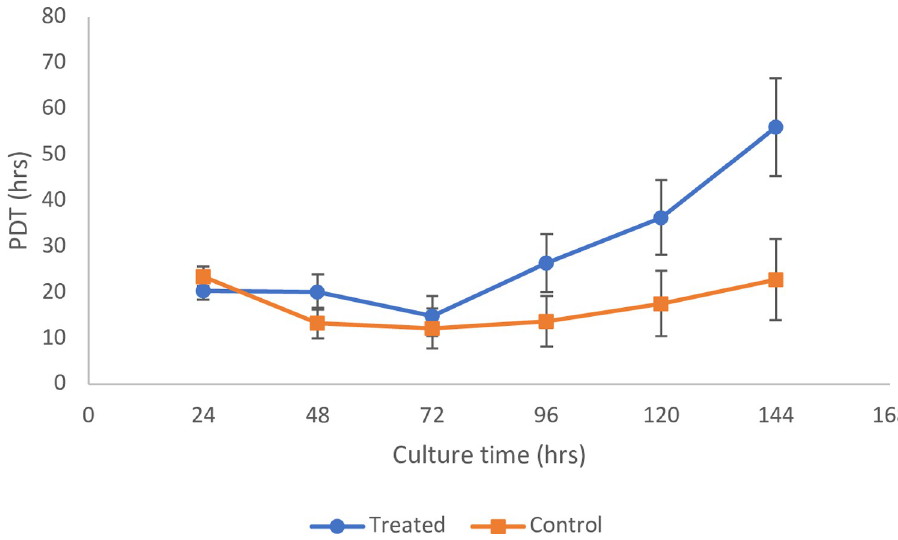
Fig 5. Comparison of population doubling time between control (untreated) and MOL treated hWJ-MSCs at each time point relative to the initial culture time. The results were presented as mean ± SD where n = 3.